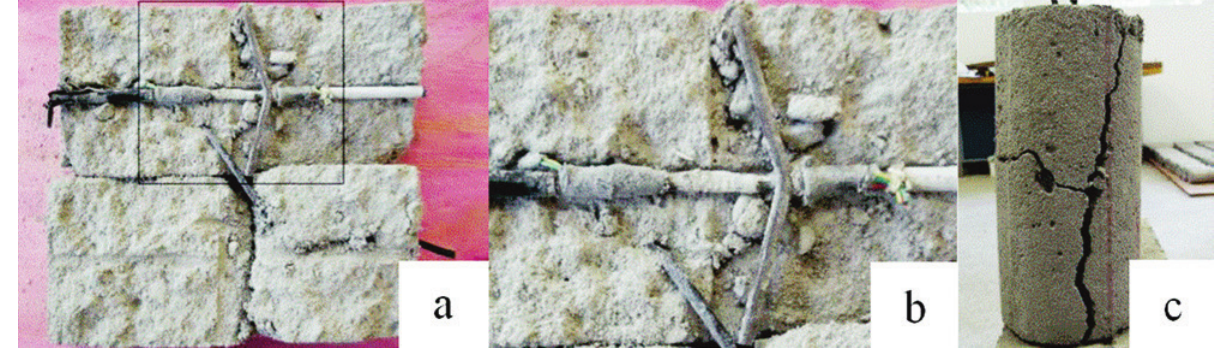
Nota: deslizamento da barra longitudinal com dobramento da barra transversal (a, b), com fissuração longitudinal e transversal do cilindro de concreto (c) Figura 11 Modo de ruptura da amostra AT3-E